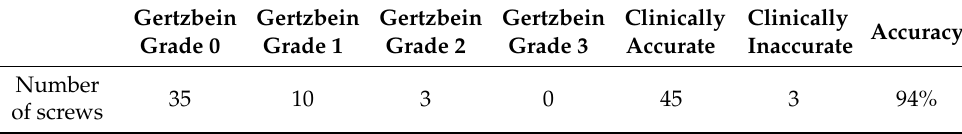
Table 1. Technical accuracy of implanted